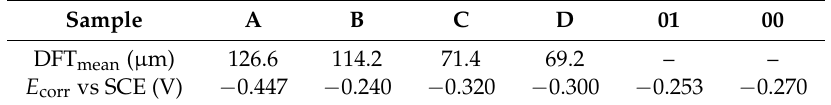
Table 4. The results of the open circuit potential after stabilization in 4% w/w NaOH